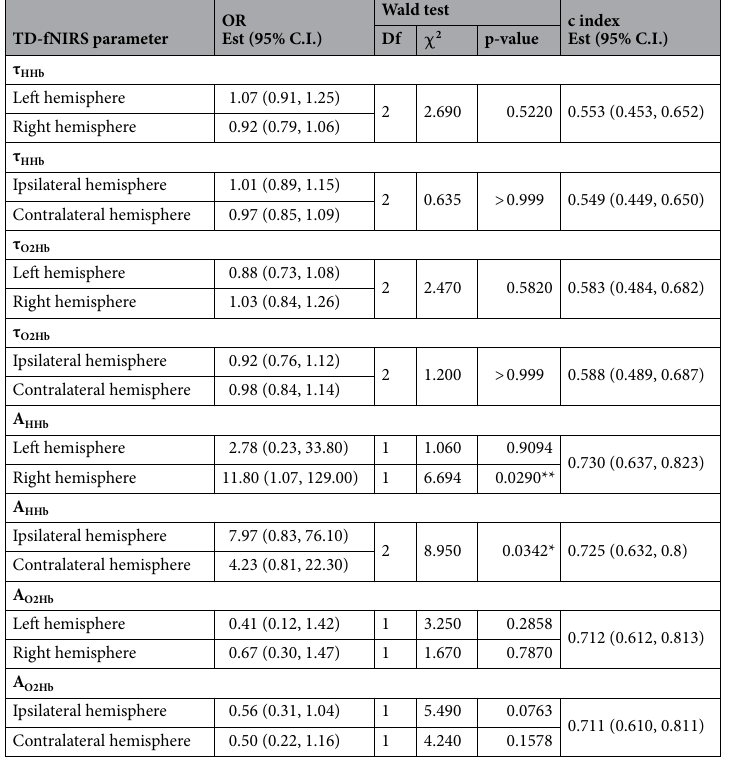
Table 3. Association and discriminant ability of TD-fNIRS parameters recorded at both hemispheres. Results obtained by estimating 8 logistic models including the same parameter obtained by the haemodynamic response at two distinct hemispheres, e.g. τ HHb from haemodynamic response recorded at the left hemisphere and τ HHb from haemodynamic response recorded at the right. Each p-value and each confidence interval were adjusted for the multiplicity of tests using the Bonferroni rule. Column 1: TD-fNIRS parameters ( A peak amplitude, τ peak latency, O 2 Hb oxy-haemoglobin, HHb deoxy-haemoglobin). Column 2: estimated OR ( Est estimates). Column 3: tests of association between parameters and pathological classification of eyes ( Df degrees of freedom. χ 2 Chi-square statistics. *p < 005, **p < 0.01). Column 4: estimates of the concordance index